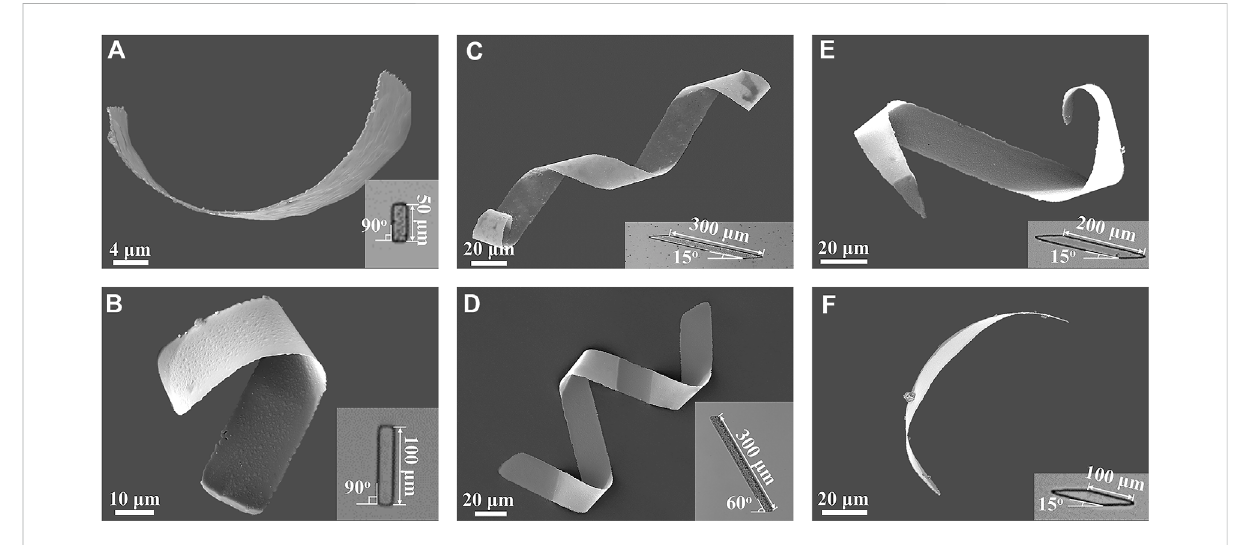
FIGURE 2 SEM images of helical microrobots fabricated using rectangular and parallelogram templates; the insets are the microscopy images of the corresponding2Dpatterns.Rectangulartemplateswithlengthsof (A) 50 μ mand (B) 100 μ m.Parallelogramtemplateswiththelengthof300 μ mand tilt angles of (C) 15 ° and (D) 60 ° . Parallelogram templates with the length of (E) 200 μ m and (F) 100 μ m and tilt angles of 15 °